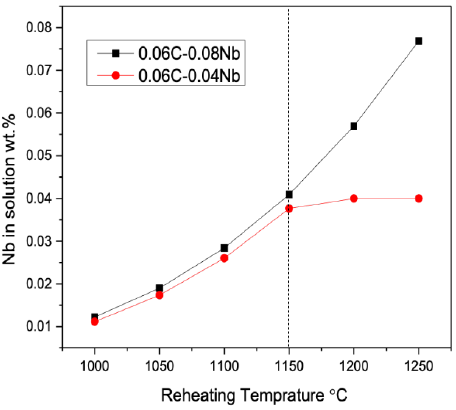
Figure 3. Calculated amount of dissolved Nb at equilibrium as a function of reheating temperature.